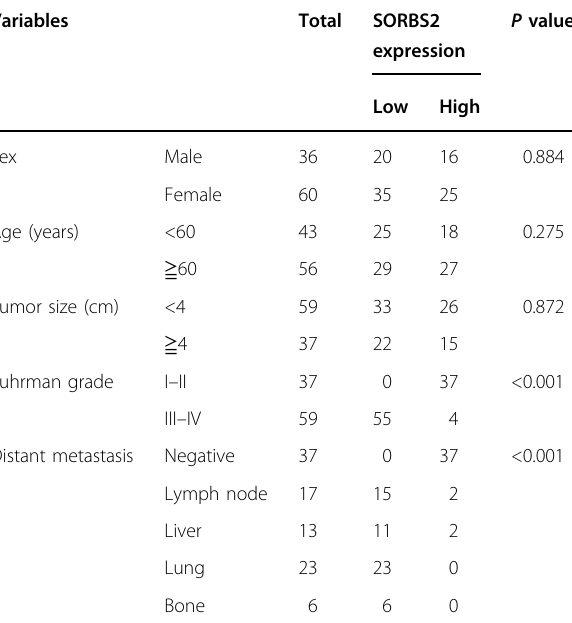
Table 1 Clinicopathological features of